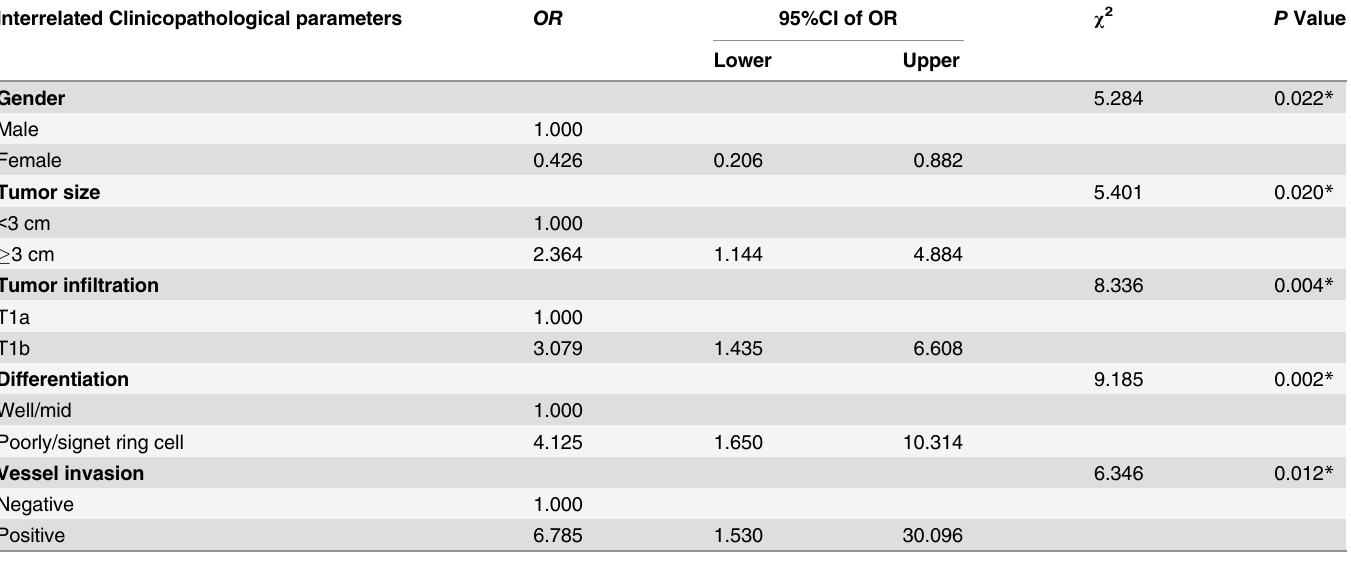
Table 2. Multinominal logistic regression analyses of LNM and interrelated clinicopathological factors. Interrelated Clinicopathological